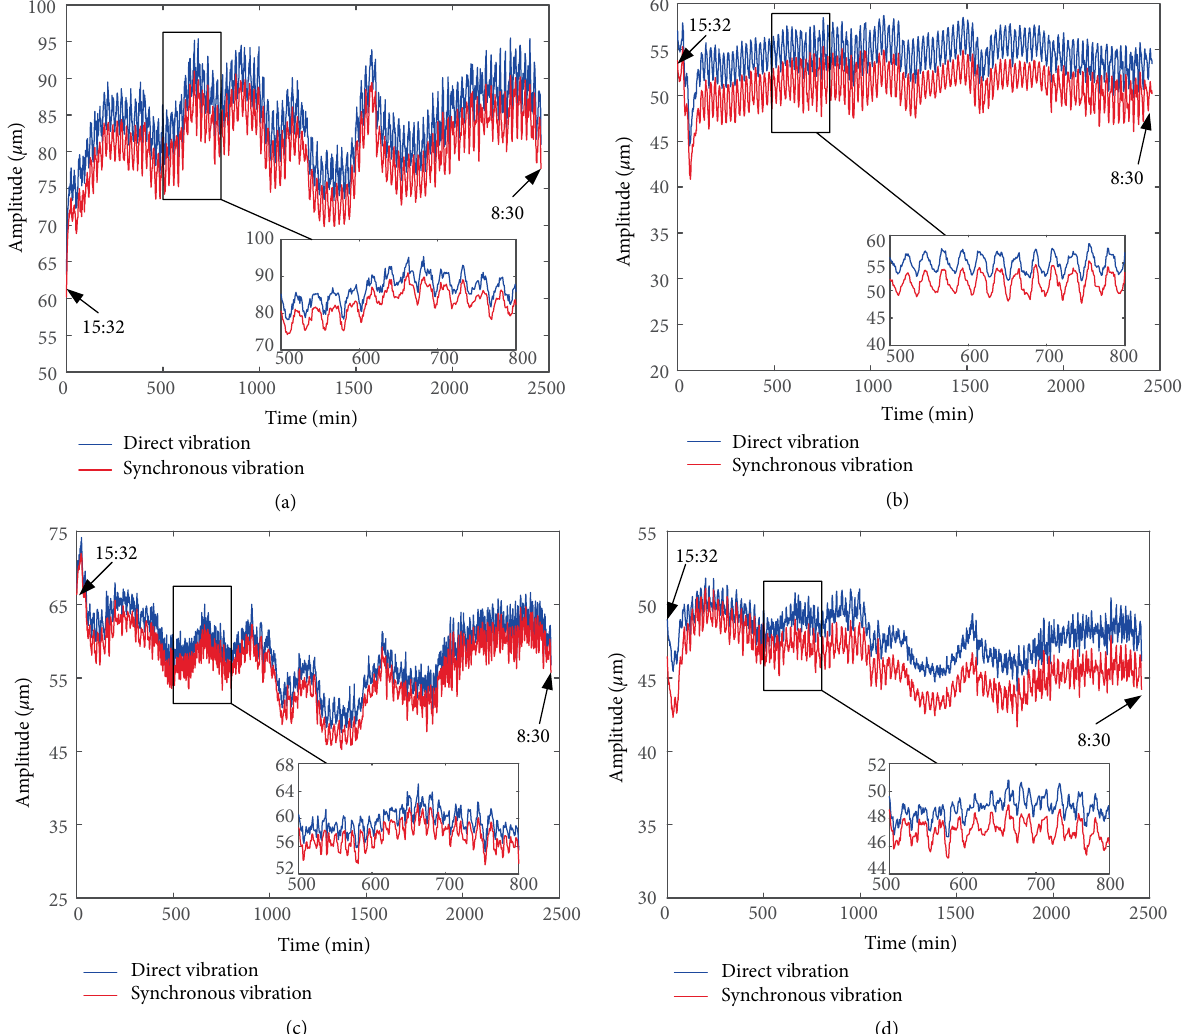
Figure 8: Vibration trend analysis diagram. (a) х -direction at bearing A. (b) y -direction at bearing A. (c) х -direction at bearing B. (d) y -direction at bearing B